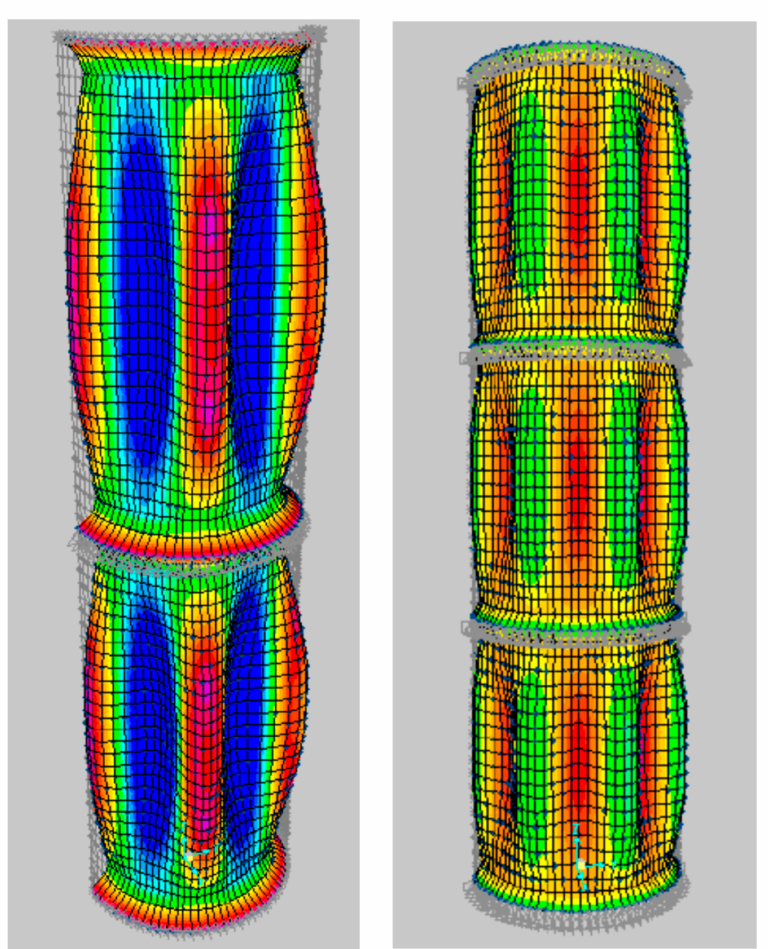
Figure 4. Geometrical instability of liners with various degrees of spacing between the